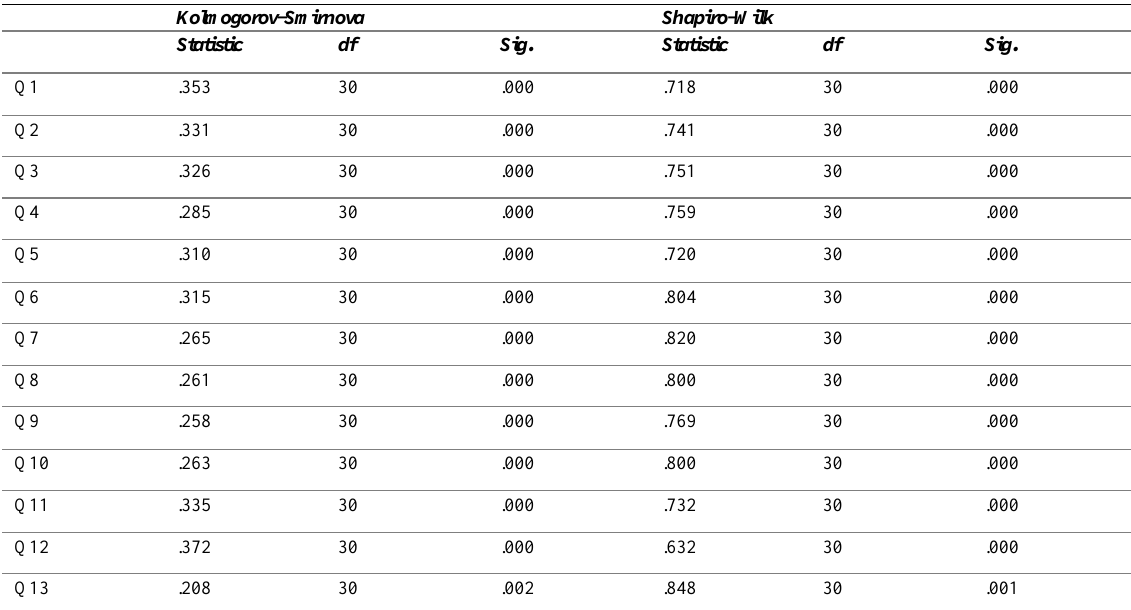
Table 3: Tests of